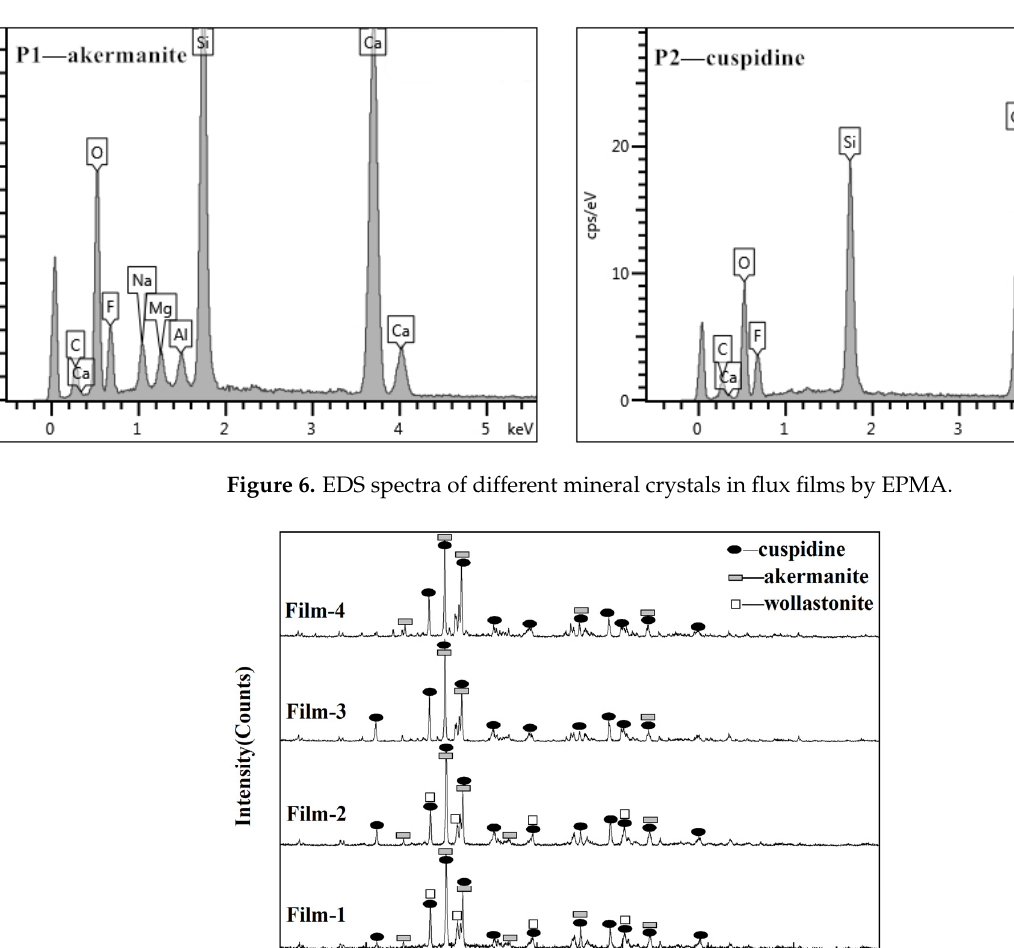
Figure 5. BSE micrographs of flux films by EPMA.